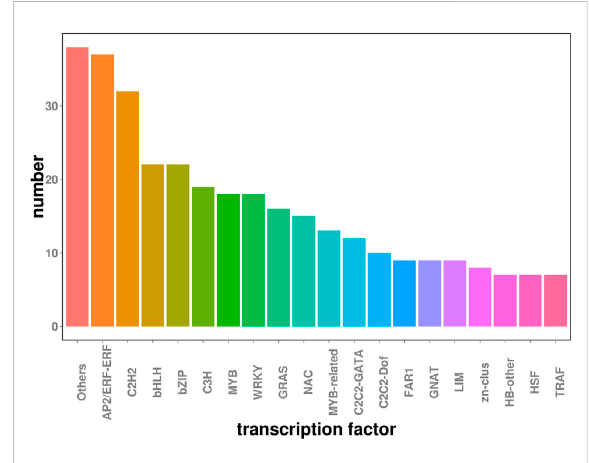
FIGURE 3 Identi fi cation of TFs in DEGs. The horizontal axis represents the names of transcription factors and the vertical axis lists the number of transcription